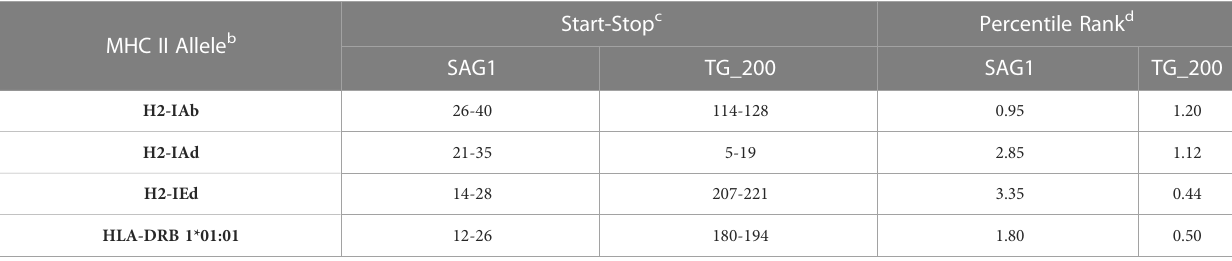
TABLE 2 IC50 values for TG_200 and SAG1 binding to MHC class II molecules, obtained using IEDB a .